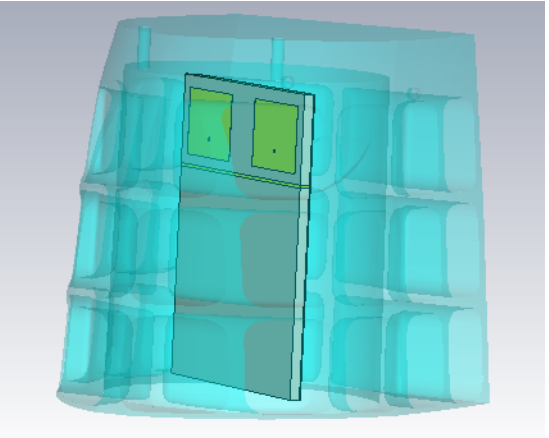
Figure 15. Anchor antennas covered by a mechanical supporting structure.